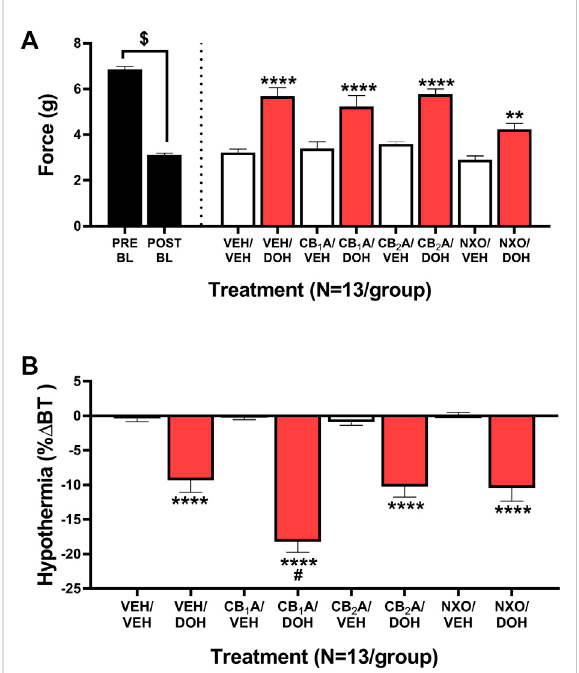
FIGURE 7 Cannabinoid and opioid mediation of the anti-allodynic and hypothermic effects of decursinol in mice with cisplatin-induced neuropathy. Mediation of the anti-allodynic (A) and hypothermic (B) effects of 50 mg/kg decursinol by CB 1 , CB 2 , and/or opioid receptors in male mice (N = 13). Mice were assessed via the